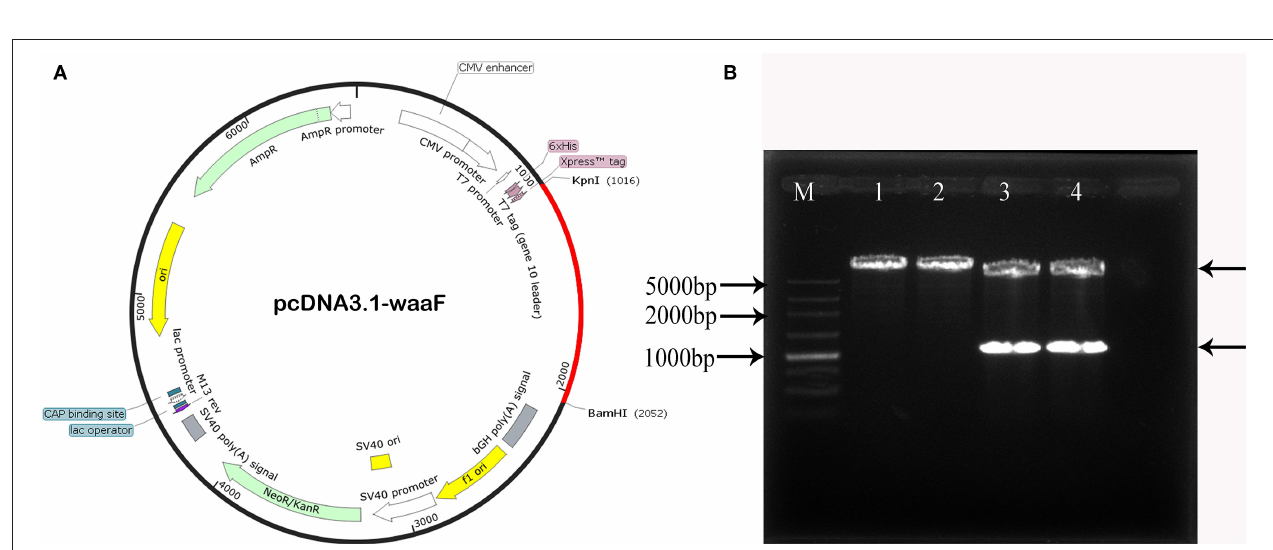
FIGURE 1 | genes was near 1,000 marker’s band, and the other was pGEM. (C,C’) the three-dimensional structure of the mutant waaF. (a–c) Are sites of amino acid which are corresponding gene deletion; (a) the missing amino acid Alanine corresponding to ACA genes; (b) the missing amino acid Glutamine corresponding to AAG genes; (c) the missing amino acid Aspartic corresponding to GCA genes. (D) The amplified sequence translation protein was analyzed by Phyre2. (a) The lack of 142–150 genes are expressed the Alanine (A), Glutamine (Q), and Aspartic acid (D), (the orange band); (b) template sequence; Thicker gray lines indicate high